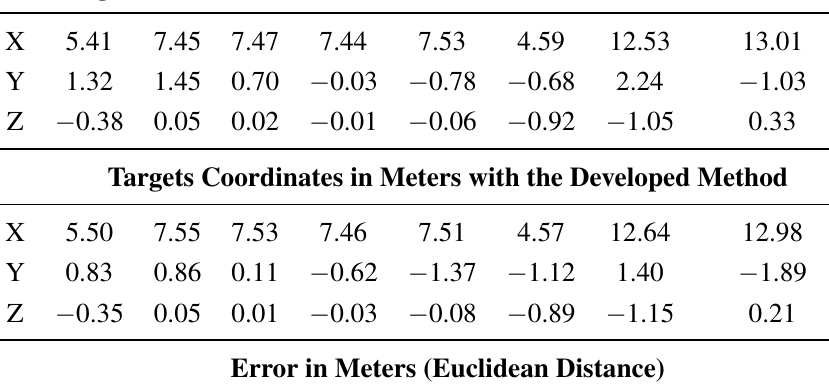
Table 2. Reconstruction results in m using the first calibration method.